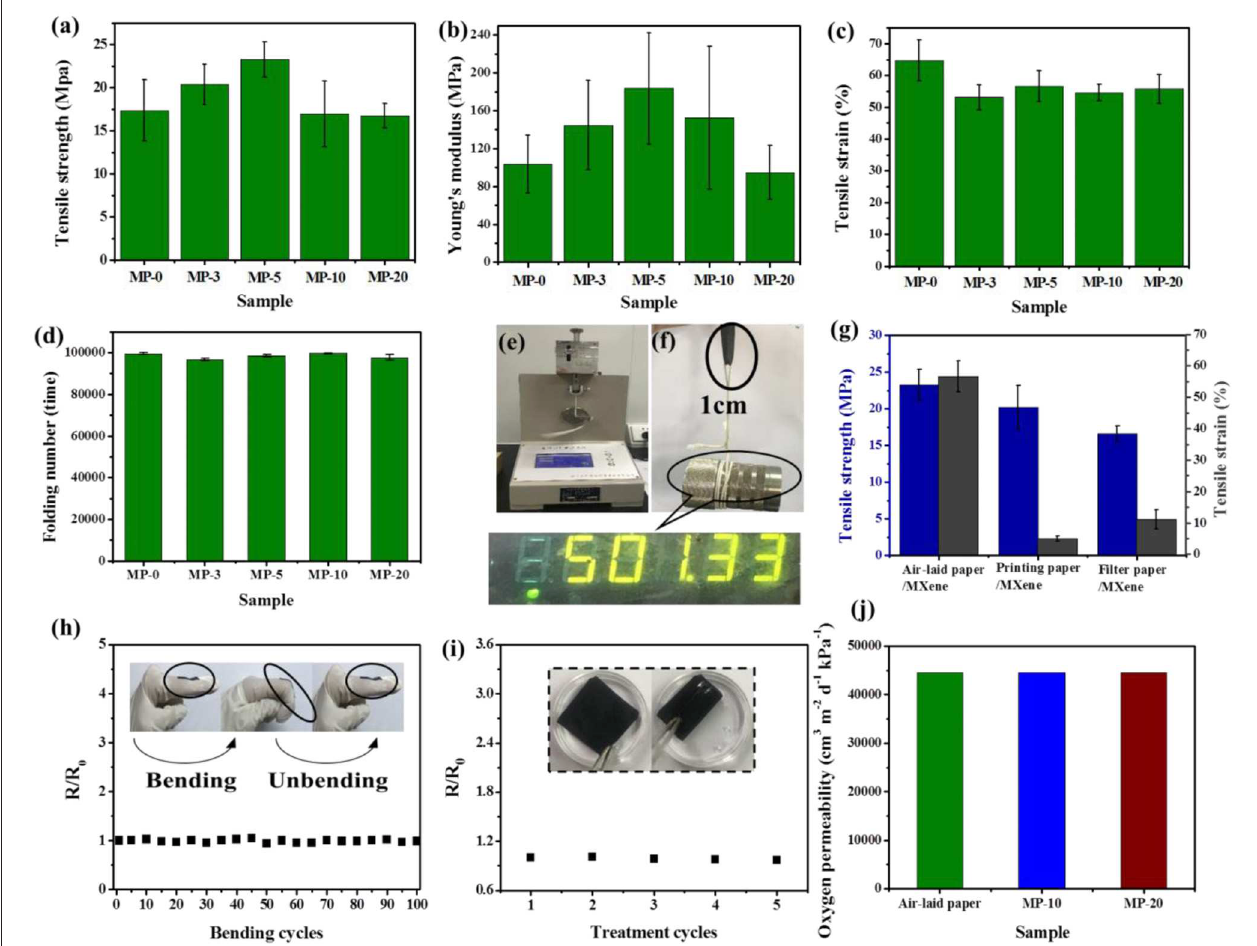
FIGURE 5 | Mechanical properties of composite paper in different dip-coating cycle times: (a) tensile strength, (b) Young’s modulus, (c) tensile strain, and (d) folding number of the composite paper in different dip-coating cycle times under a loading of 9.8N; (e) digital image of the paper folding endurance instrument; (f) digital image of the MP-5, which can bear more than 500g weight without breaking; (g) tensile strength and tensile strain of the MP-5, MXene/printing paper-5, and MXene/filter paper-5; (h) stability of MP-20 with bending test in different cycles; (i) stability of MP-20 in simulated artificial sweat; (j) oxygen permeabilities of the original air-laid paper, MP-10 and